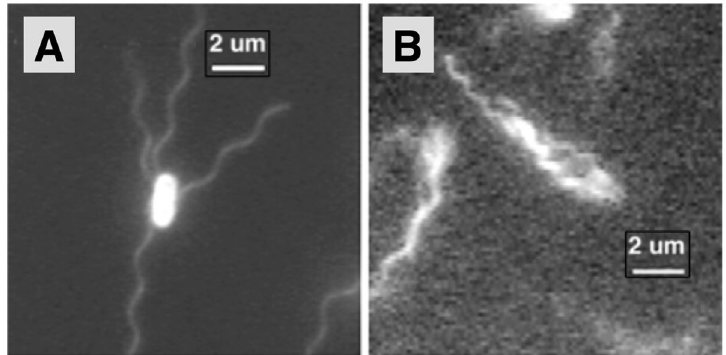
Figure 1. Swimming E. coli bacteria. ( A ) Peritrichous bacterium with multiple flagella spatially distributed around the cell body. ( B ) Flagellar filaments are located behind the swimming cell in a helical bundle whose rotation pushes the cell forward. Reproduced from Turner, Ryu & Berg (2000) J. Bacteriol ., 182 , 2793–2801 6 . Copyright 2000 American Society for Microbiology.